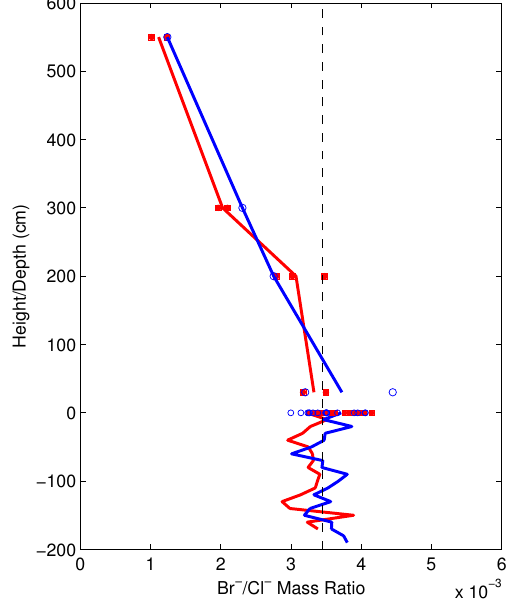
Figure 3. Br − / Cl − mass ratios for sea ice (negative heights), sur- face snow (height of 0), and blowing snow (height above snow sur- face). Blowing snow lines connect averages for each basket height. Butter Point Site samples are shown in red filled-in squares and red lines, while Iceberg Site samples are shown in blue open circles and blue lines. The standard ocean Br − / Cl − mass ratio is shown as a black dashed line (Morris and Riley, 1966).